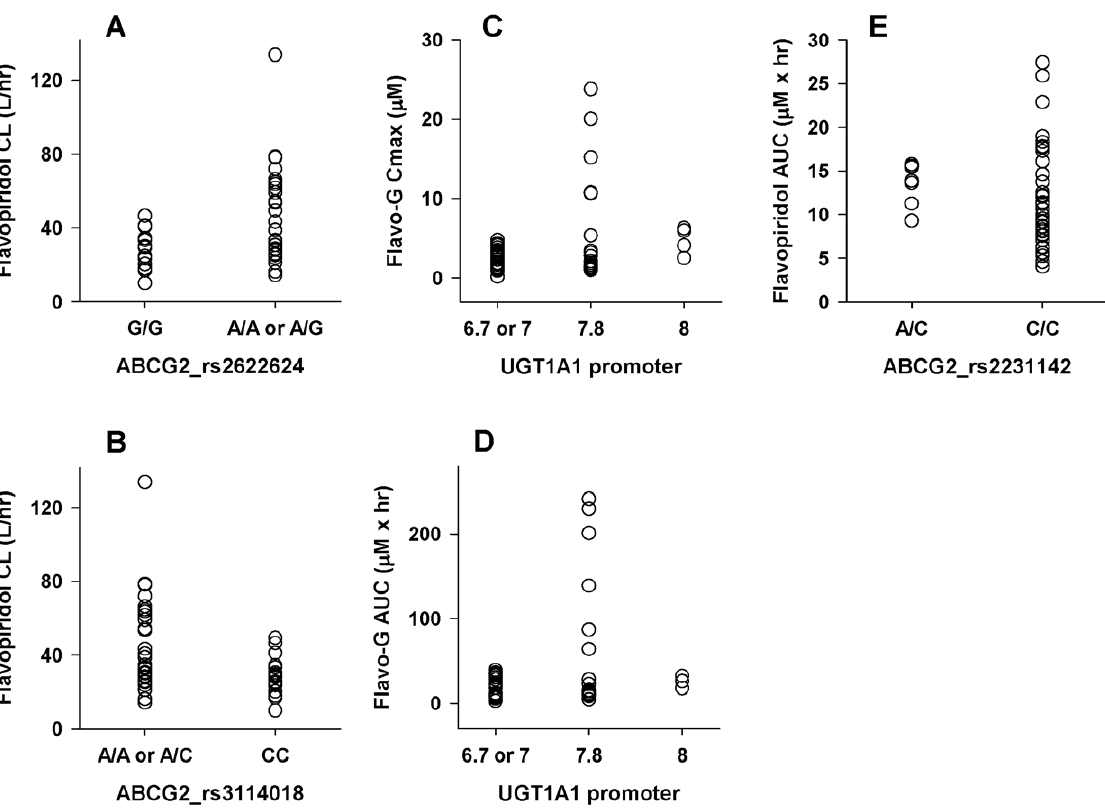
Figure 6. Association of PGx and PK from the phase II dataset. Flavopiridol and flavo-G PK parameter estimates from the phase II study was evaluated for relationships with PGx. Presented are flavopiridol CL associations with ABCG2 rs2622624 (p=0.008, Panel A) and rs3114018 (p=0.004, Panel B); UGT1A1*28 (promoter) polymorphisms associated with flavo-G Cmax (p=0.02, Panel C) and AUC (p=0.04, Panel D); the ABCG2 rs2231142 SNP was weakly associated with flavopiridol AUC (Panel E, p=.08); For plots C and D, the x-axis indicates the number of promoter TA repeats for both gene copies (6.7=6 and 7 TA repeats; 7=7 TA repeats for each gene copy; 7.8=7 and 8 TA repeats; 8=8 TA repeats for each gene copy).